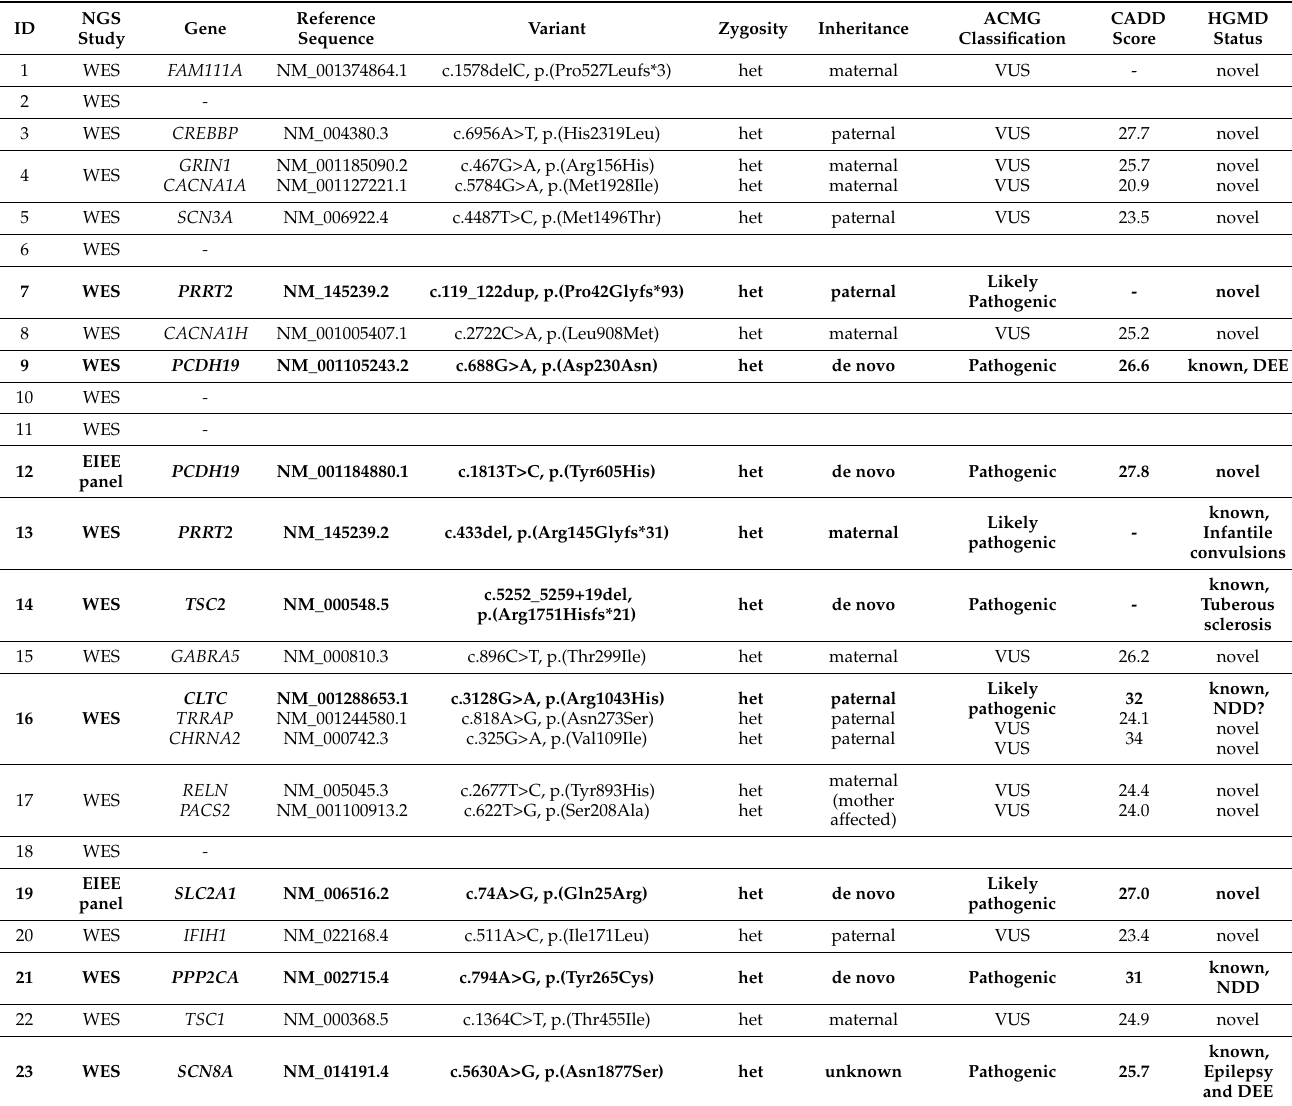
Table 1. Results of NGS study in a cohort of AEFI patients. Pathogenic/likely pathogenic variants in ACMG classification are bold. ACMG classification was conducted using Varsome (https://varsome.com (accessed on 1 August 2022)). HGMD status refers to HGMD Professional 2021.4 (https://my.qiagendigitalinsights.com (accessed on 25 March 2022)). Indicated variants are those in genes engaged in neurodevelopment, absent, or with extremely low frequency in gno- mAD, with in silico predictions as likely pathogenic, including CADD score above 20 (cut-off level). ACMG—American College of Medical Genetics and Genomics; VUS—variant of uncertain sig- nificance; EIEE—early infantile epileptic encephalopathy; DEE—developmental and epileptic en- cephalopathy; NDD—neurodevelopmental